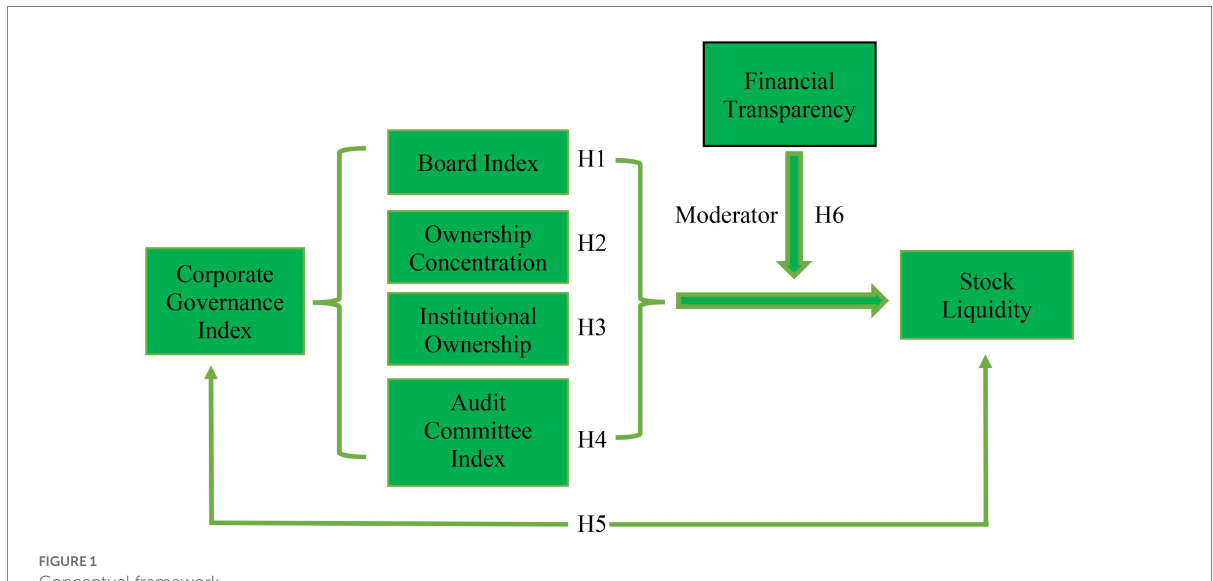
FIGURE 1 Conceptual